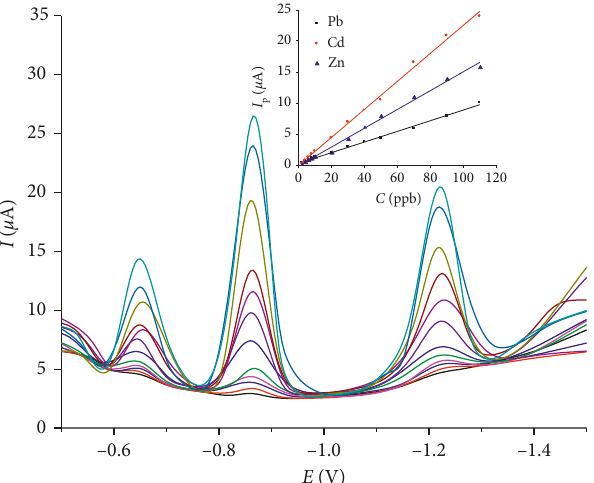
Figure 4: SqW-AdSV voltammograms using BiFE under optimal conditions in solutions containing different concentrations of Pb, Cd, and Zn (2–110ppb each metal). Upper small figure is a linear regression line for Cd (red), Pb (blue), and Zn (black) (conditions: 0.01 M HEPES buffer solution pH 6.5; [oxine] � 726ppb; [Bi(III)] � 640ppb; E acc.p � –1.6V; t acc.p � 240s; E str.p � –0.7V; t str.p � 15s; potential scanning range E range � –0.35 ÷ –1.5V; square-wave amplitude Δ E � 0.05V; potential step U step � 0.006V; increment time t step � 0.3s; measuring time t meas � 3ms; electrode rotating rate ω � 2000rpm). Table 4: Comparison of LOD and linear range related to different electrodes and methods for determination of analytes. Electrode Method Analyte LOD (ppb) Linear range (ppb) Ref.